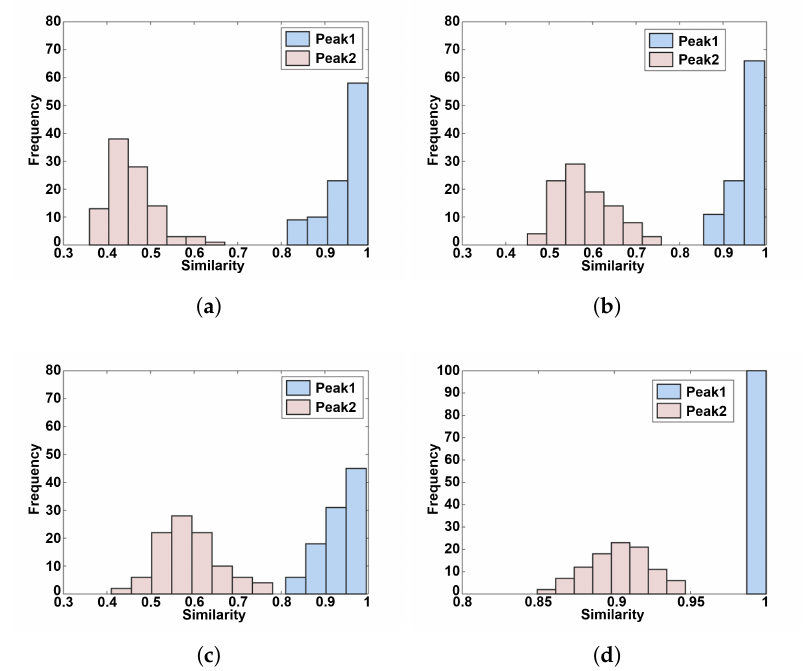
Figure 9. Distributions of margins between peak 1 and peak 2 for ABC, CI, CCH, and TFCM ( SNR =